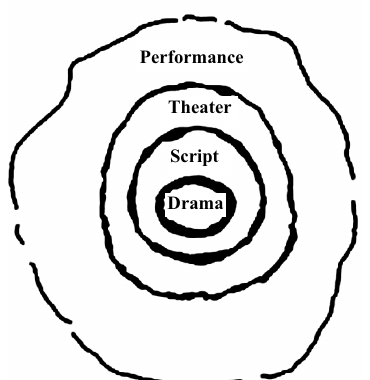
Fig. 1. Drama, script, theater, performance